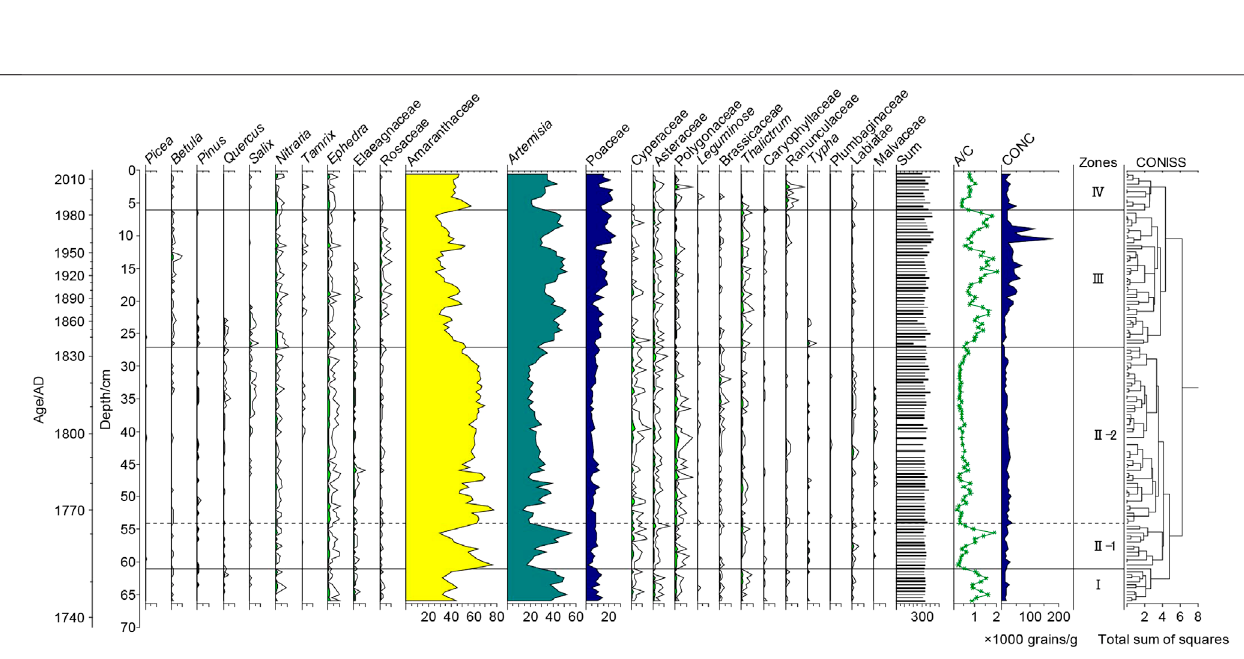
Frontiers in Earth Science |